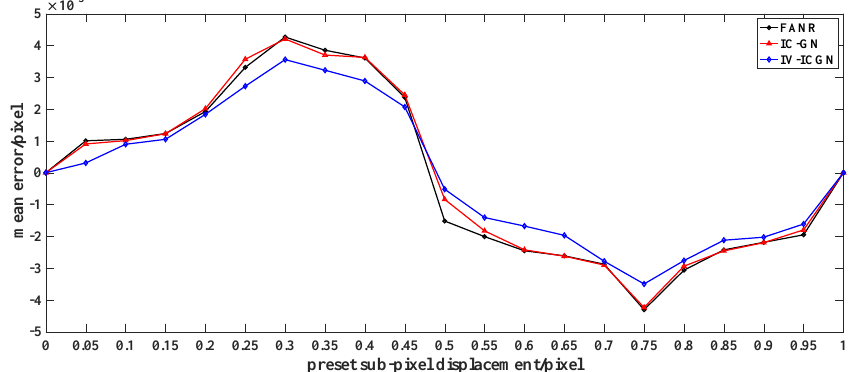
Figure 9. Comparison curve of the mean error in the u direction of three algorithm.